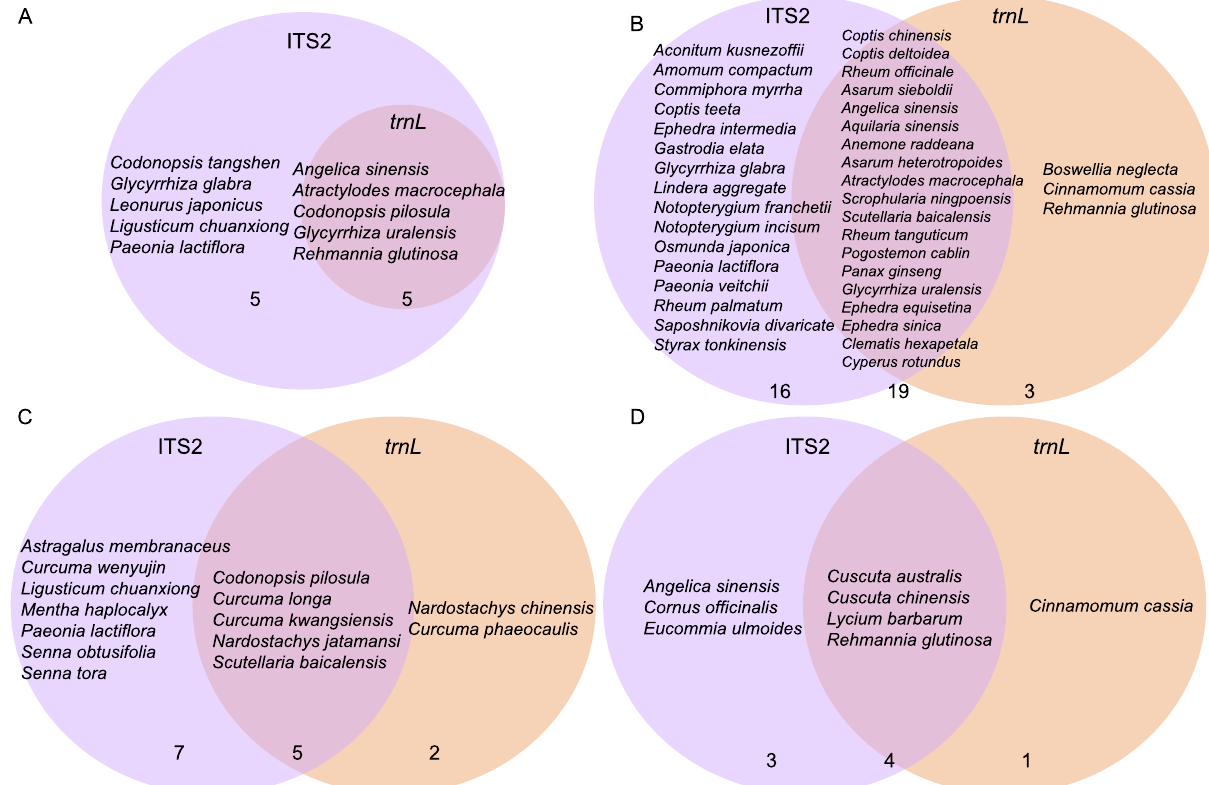
Figure 7. The specific and shared prescribed herbal species of TCM preparations based on ITS2 and trnL . ( A ) BYW; ( B ) DHW; ( C ) NJW; ( D ) YGW. The numbers below the Venn diagram mean the number of prescribed herbal species detected based on ITS2, trnL only, and the intersection of the two.